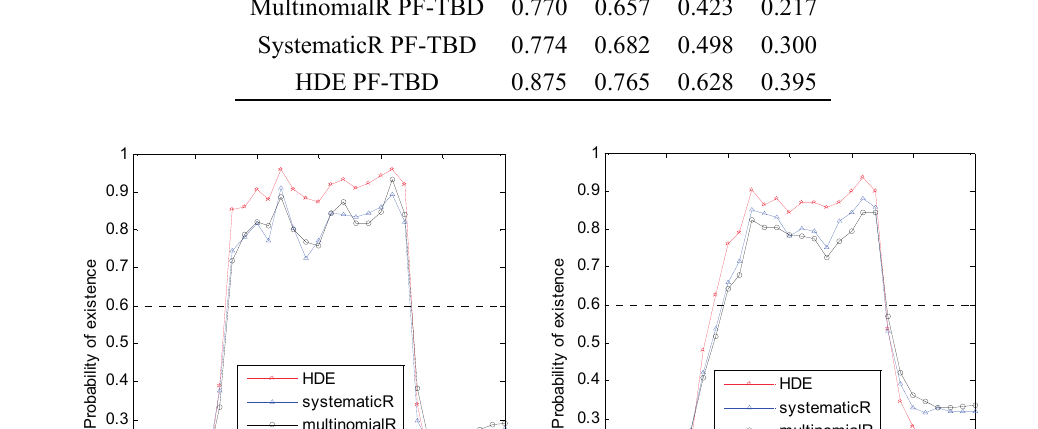
Table 1. The average of the probability of detection for the constant velocity (CV) model. R, resampling; PF, particle filter; TBD, track-before-detect; HDE, hybrid differential evolution.